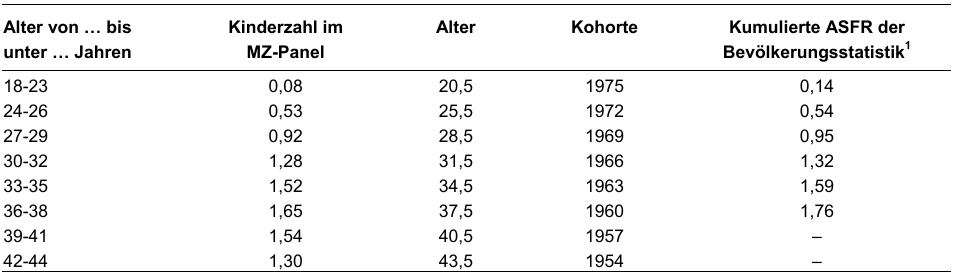
Tab. A2: Vergleich der kumulierten kohortenspezifischen Fertilitätsziffern (CSFR) aus der Bevölkerungsstatistik und der auf Basis des Mikrozensus-Panels 1996 – 1999 rekonstruierten durchschnittlichen Kinderzahl je Frau – Ergebnisse für